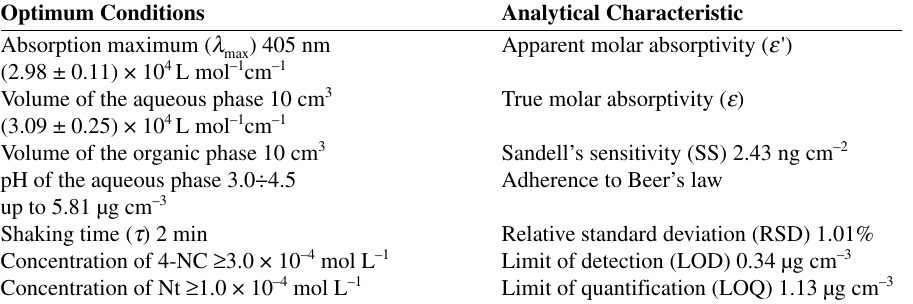
Table 1. Optimum extraction-spectrophotometric conditions and analytical characteristics of the system